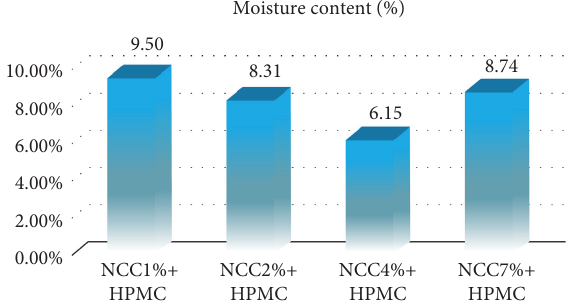
Figure 7: The moisture content (%) value for 1%, 2%, 4%, and 7% NCC with hydroxypropyl methylcellulose (HPMC).